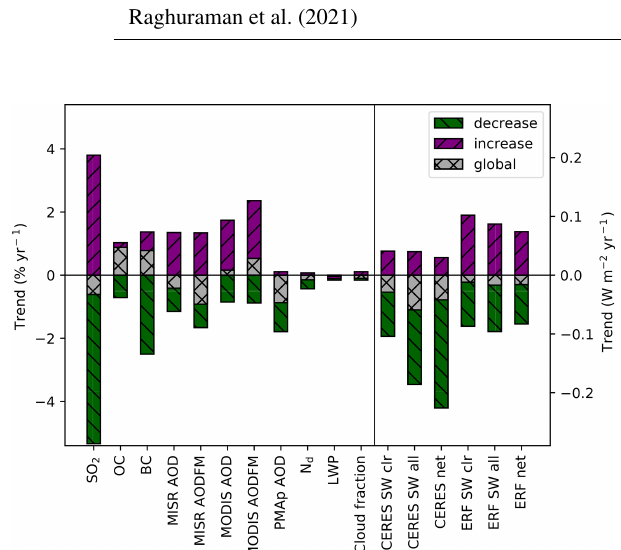
Figure 6. Mean values derived from the maps in Figs. 1 to 4, aver- aged over (green/downward hatching) the regions with substantial negative trends (defined as larger than 0.05Wm − 2 yr − 1 in abso- lute terms; isolines in Fig. 4) in ERF solar clear-sky situations from RFMIP (Fig. 4d) and (purple/upward hatching) substantial positive trends. The grey bar (crosses) is the global mean between 60 ◦ S and 60 ◦ N. The regions with negative trends cover 7.3% of the Earth surface, the ones with positive trends, 1.1%. The AODFM is only retrieved over oceans, and the PMAp time series only spans 10 years from 2008 to 2017. From left to right: Trends in emissions of SO 2 , OC, and BC, in AOD and AODFM from MISR, MODIS, and Metop-A, in cloud droplet concentration N d , LWP and cloud frac- tion from MODIS. All these are provided in units of %yr − 1 and refer to the left axis. Trends in CERES retrievals of solar clear-sky, solar all-sky, and net all-sky radiation, as well as in model-derived ERF for solar clear-sky, solar all-sky, and net all-sky radiation are shown in units of Wm − 2 yr − 1 (right axis) and are inverted in sign: negative trends here are for reduction in magnitude (less negative fluxes/effective